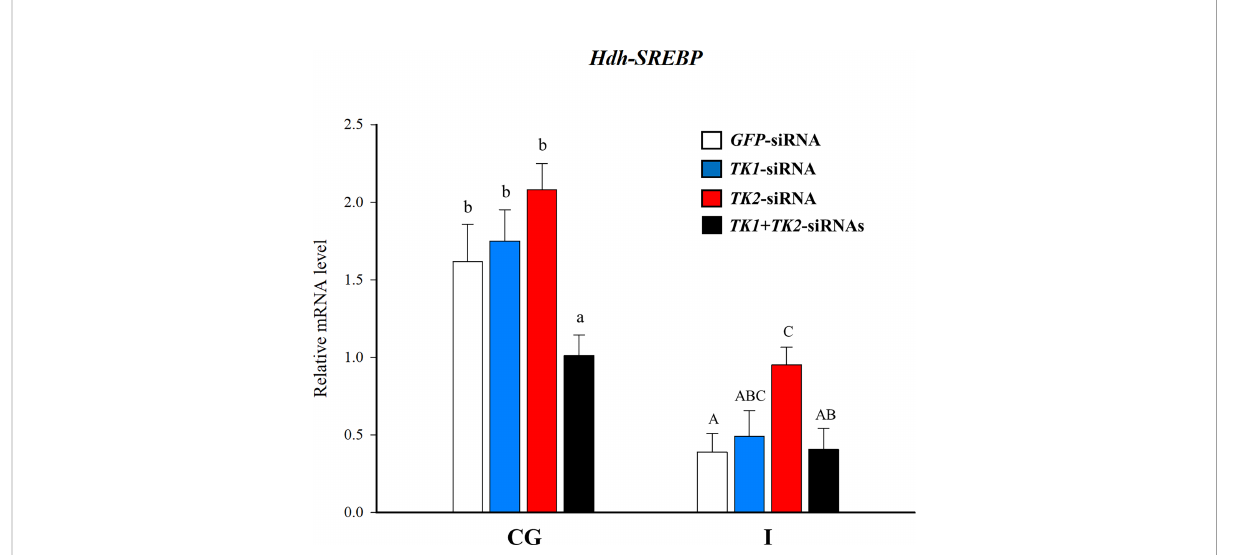
FIGURE 12 Relative expression levels of Hdh-SREBP in the cerebral ganglion and intestine after administration of Hdh-TK1 and/or Hdh-TK2 speci fi c siRNAs (50 m g/ind.). As a control, an equal amount of GFP -speci fi c siRNA was administrated. At 44 h post-injection, tissues were sampled and relative Hdh-SREBP transcript levels were measured by real-time quantitative PCR. All data are presented as the mean ± SEM (n = 7 or 8). Different upper and lower case letters on the bars indicate statistically signi fi cant differences (p < 0.05). CG, cerebral ganglion; I,